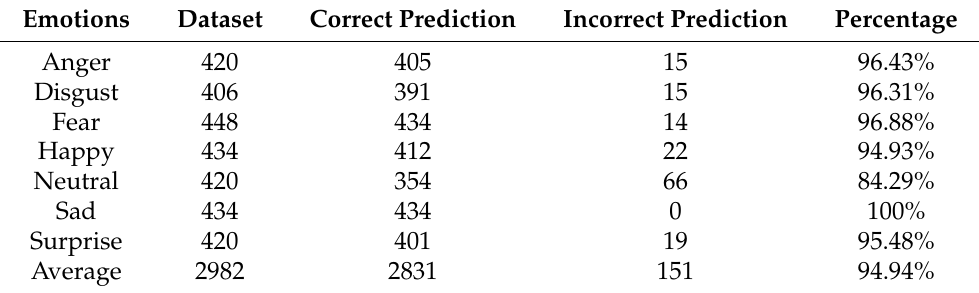
Table 25. Cross dataset testing result of the proposed model after 100 epochs.